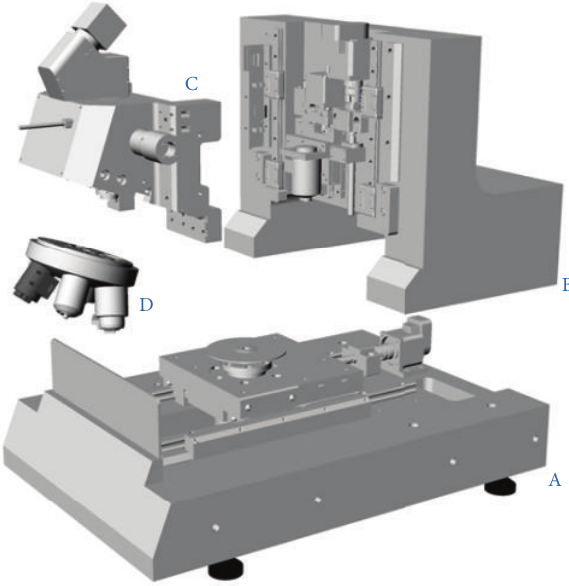
Figure 1: The exploded view of the CDA-101A. Part A, the granite base with the spindle mounted on the 𝑋 -stage. Part B, the vertical granite arch with the AFM stage and the 𝑍 -stage. Part C, the optical housing with CCD camera and automatic turret mount. Part D, the automatic turret with glide, burnish, scriber, and optical objectives. Read the text for further detailed